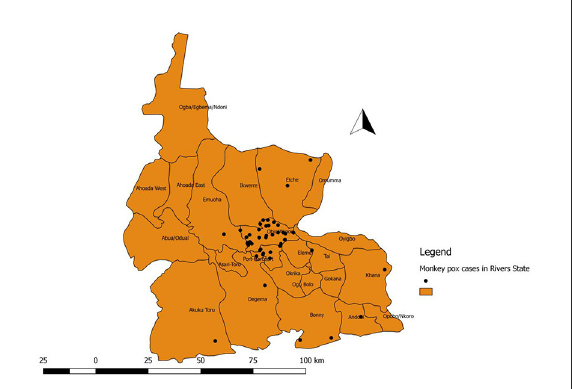
FIGURE1 Distribution of confirmed (positive) cases of Monkey pox in the Local Government Areas of Rivers State, Nigeria, January 2017-June